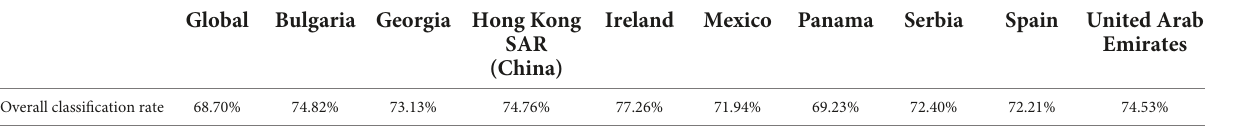
TABLE 3 Overall average classification rate of the models estimated from the 10 plausible